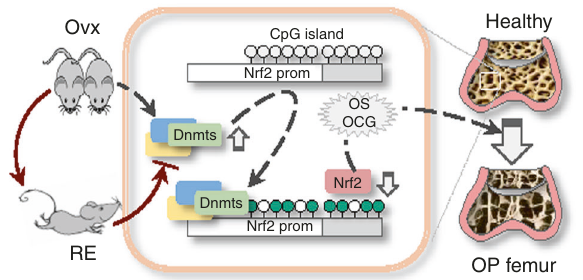
Fig. 7 A schematic diagram of mouse running exercise, Nrf2 promoter demethylation and protection against osteoporosis (OP). Ovariectomized mice display increased femoral Dnmt1/3a/3b (Dnmts), Nrf2 promoter hypermethylation and Nrf2 suppression, which promote oxidative stress (OS), osteoclastogenesis (OCG) and OP (dashed line). Running exercise (RE, solid line) normalizes